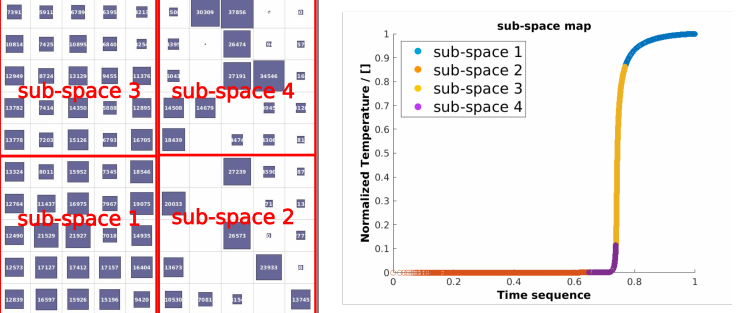
Figure 3. SOM clustering map converted into subspace map ( left ) and temperature plot of subspace clusters ( right